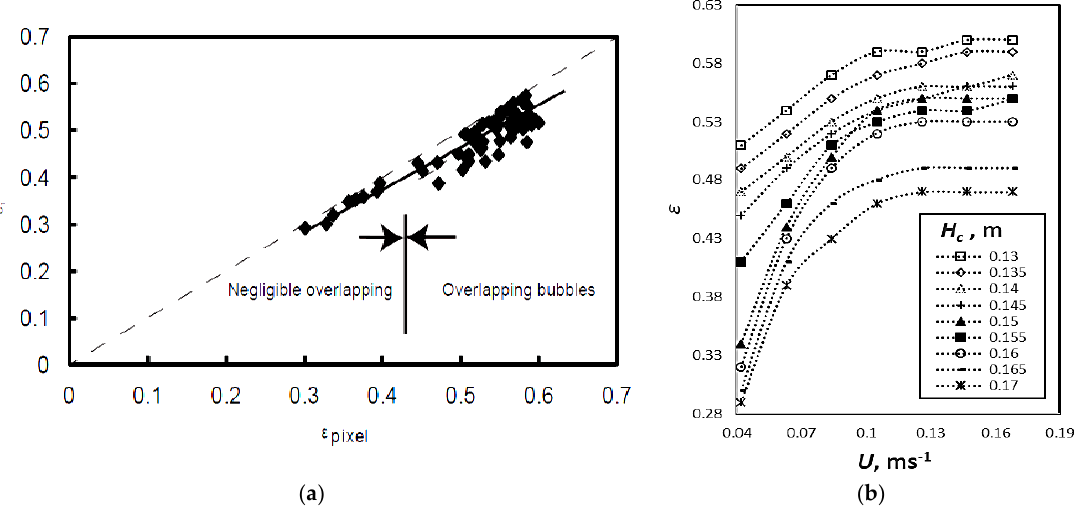
Figure 10. ( a ) Comparison between gas holdup measured by height estimation method and PI method. ( b ) Variation of ԑ with U and H c .